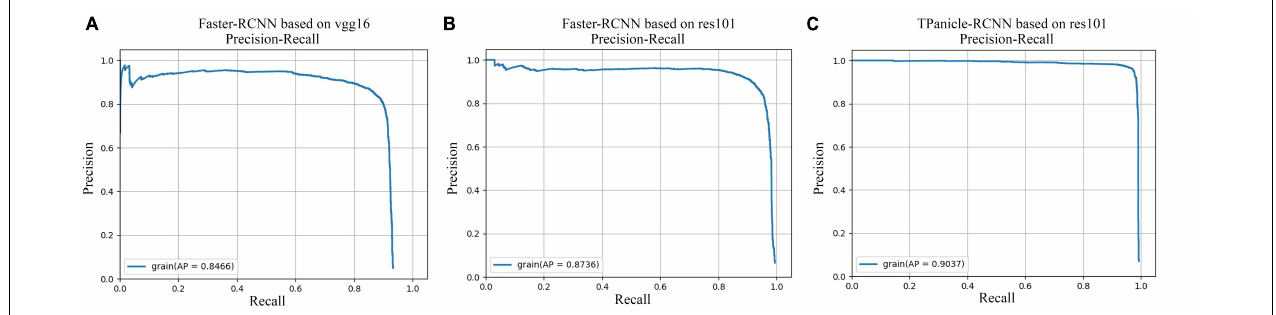
FIGURE 7 | Comparisons of precision–recall curves, (A) Faster-RCNN based on vgg16, (B) Faster-RCNN based on ResNet101, (C) TPanicle-RCNN based on ResNet101.